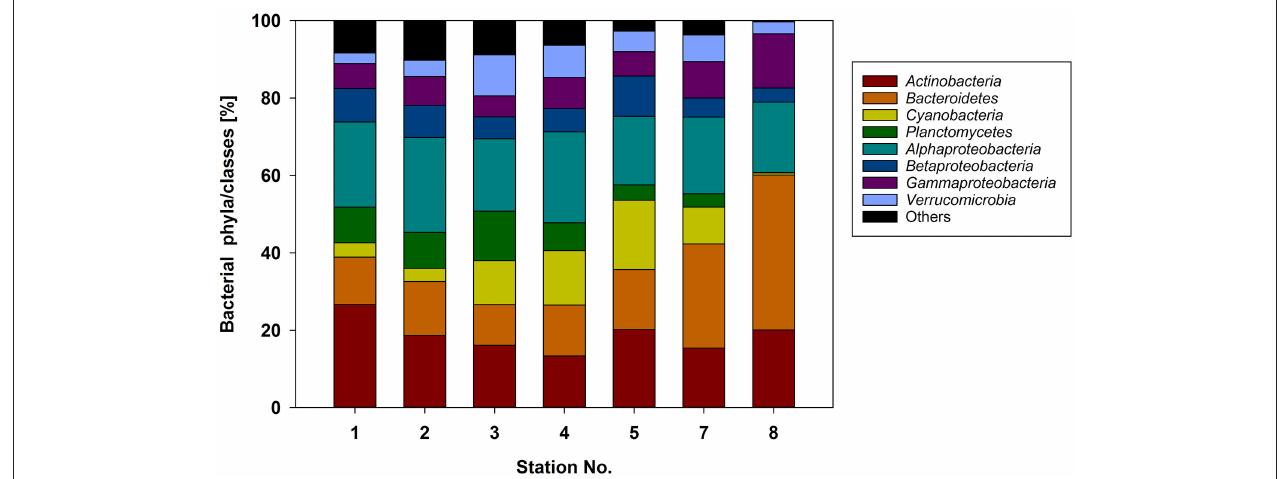
FIGURE 4 | Relative abundance of the major bacterial phyla/classes at the different stations sampled based on 16S rRNA gene analysis.